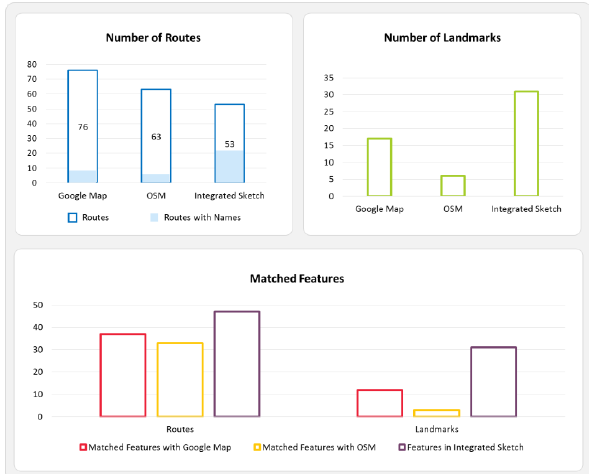
Figure 5. Comparison of the integrated sketch maps with OSM and Google